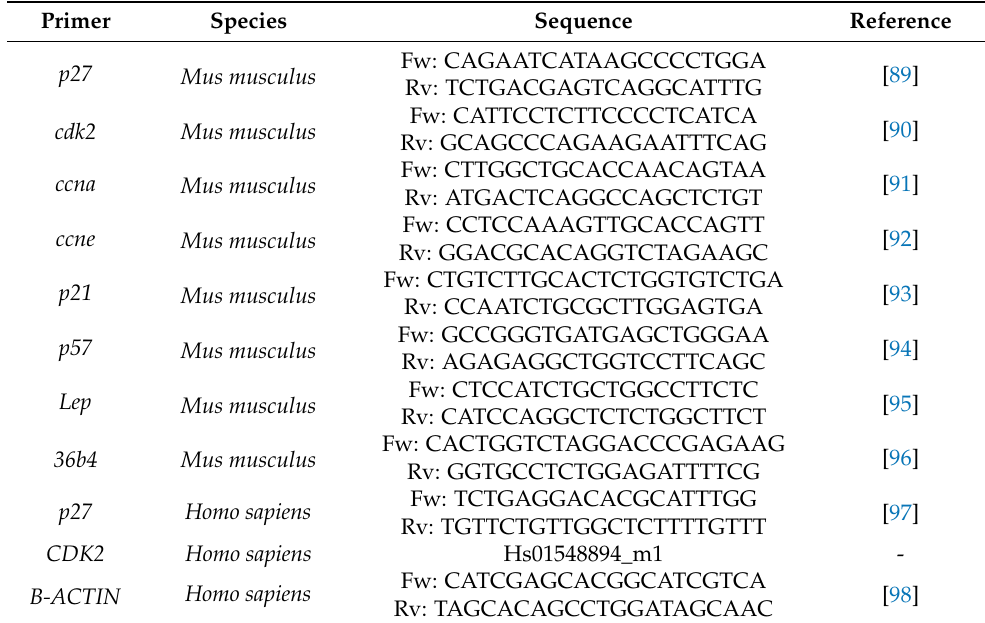
Table 4. Sequences of primers used in the